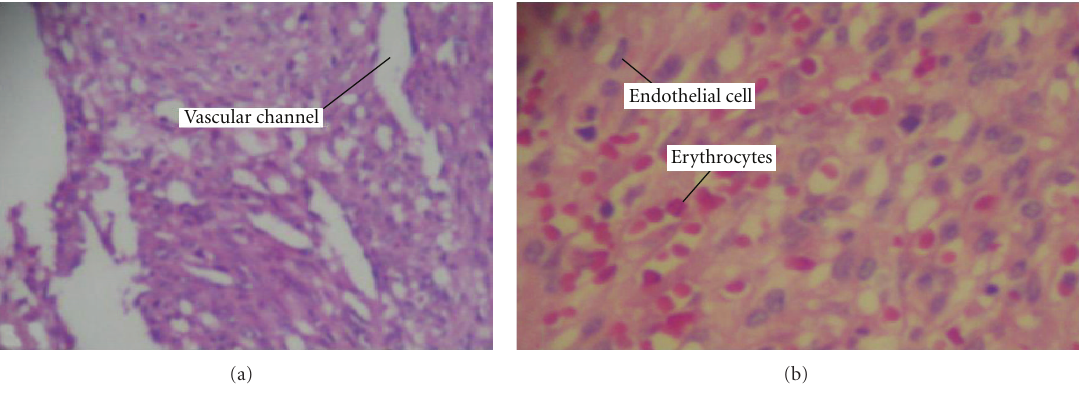
Figure 2: (a) Proliferation of spindle cells forming vascular channels with prominent endothelial cells, (b) vascular neoplasm with solid areas, su ff used with red blood cells and endothelial cells with hyperchromatic